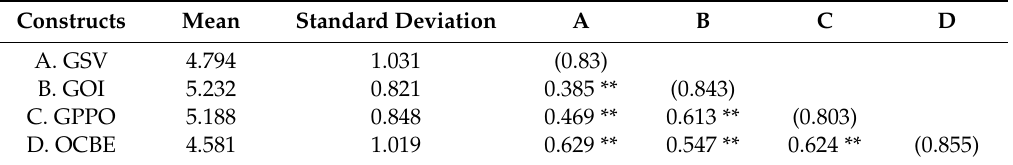
Table 2. Means, standard deviations and correlations of the constructs.